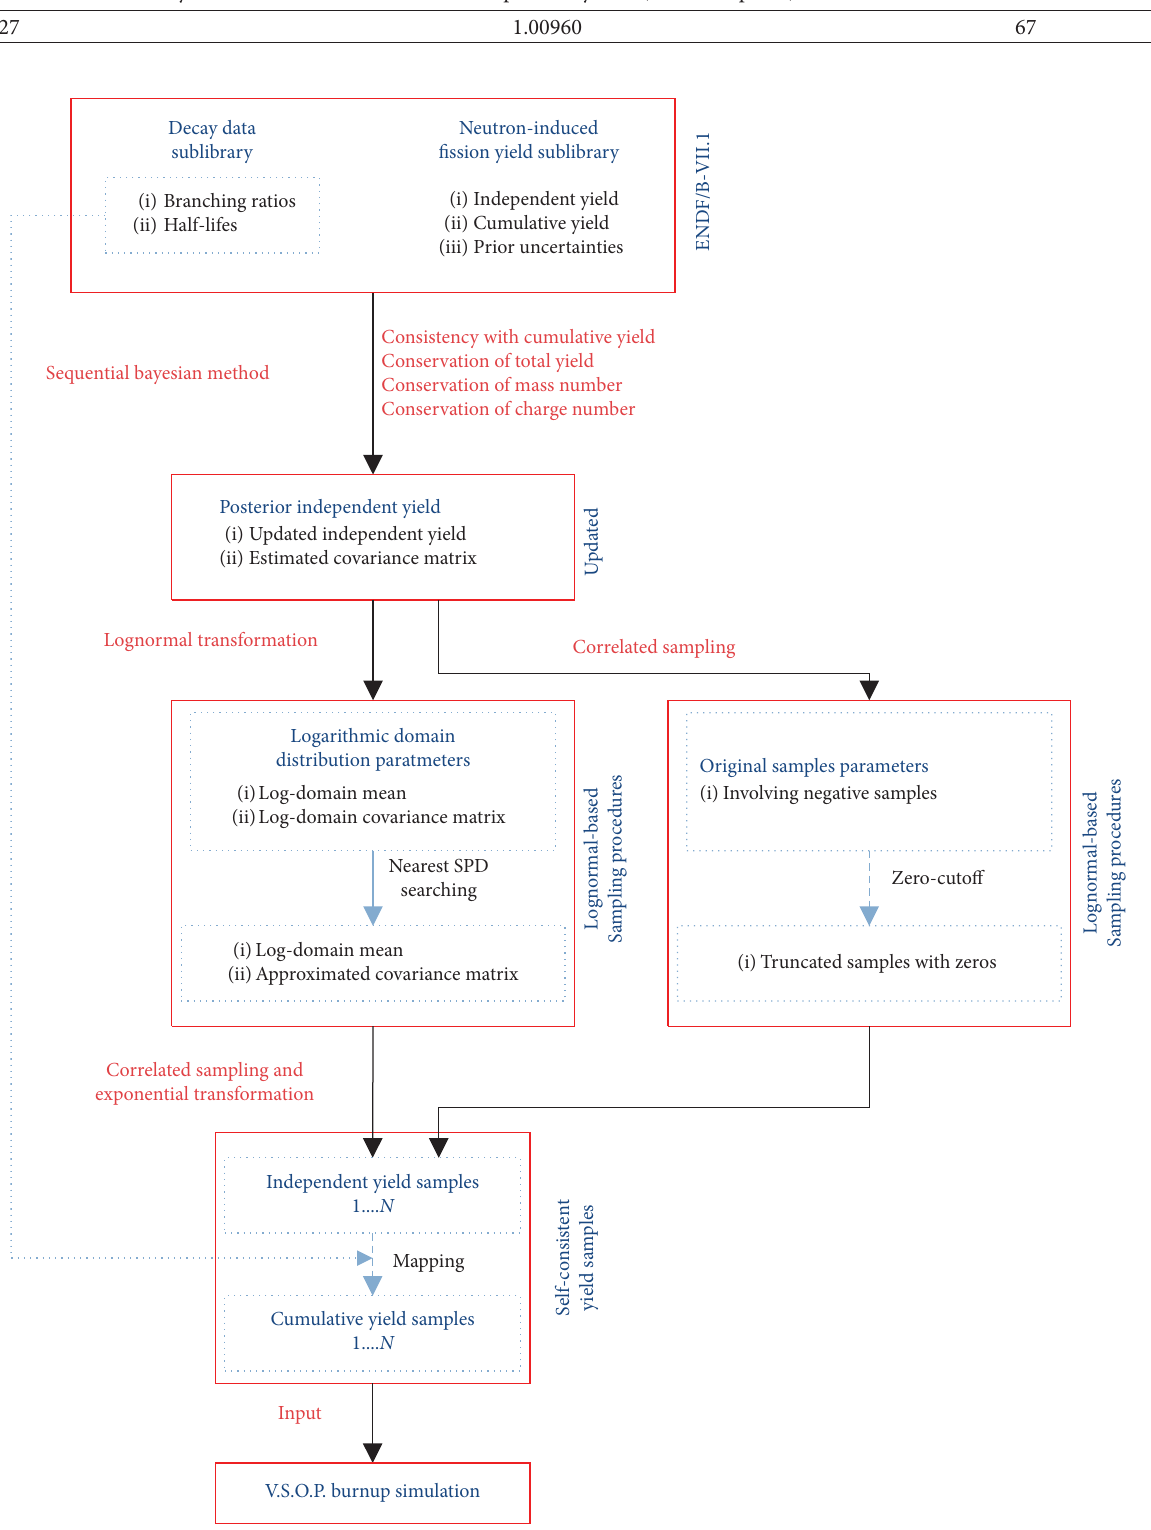
Figure 4: Flow chart of fission product yields uncertainty